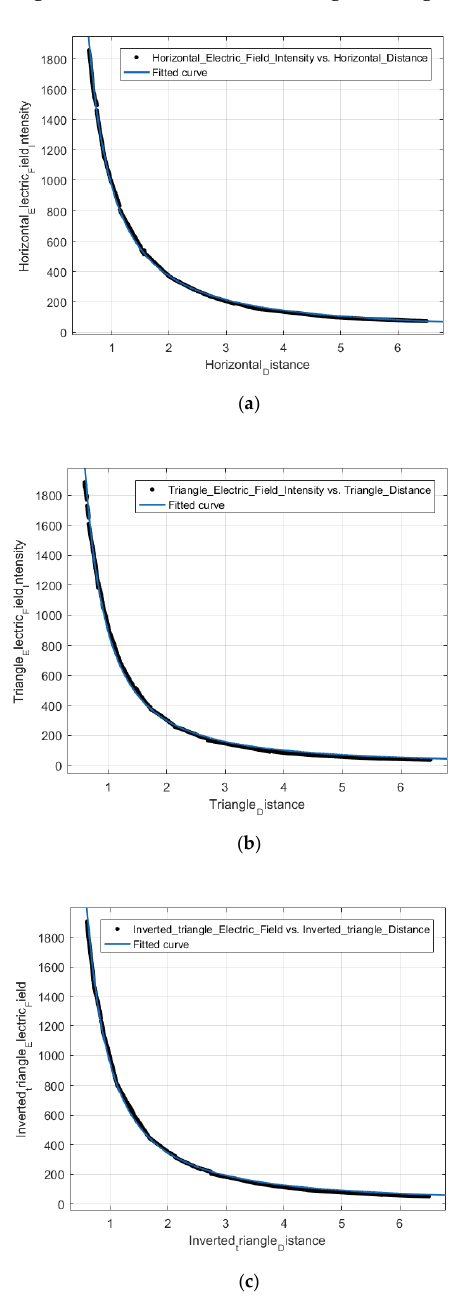
Figure 15. Fitting curves of electric field strength and distance for different arrangements: ( a ) Horizontal arrangement; ( b ) Triangular arrangement; ( c ) Inverted triangular arrangement. The fitted equations for the three different arrangements and the corresponding 𝑅 2 are shown in Table 2 below.